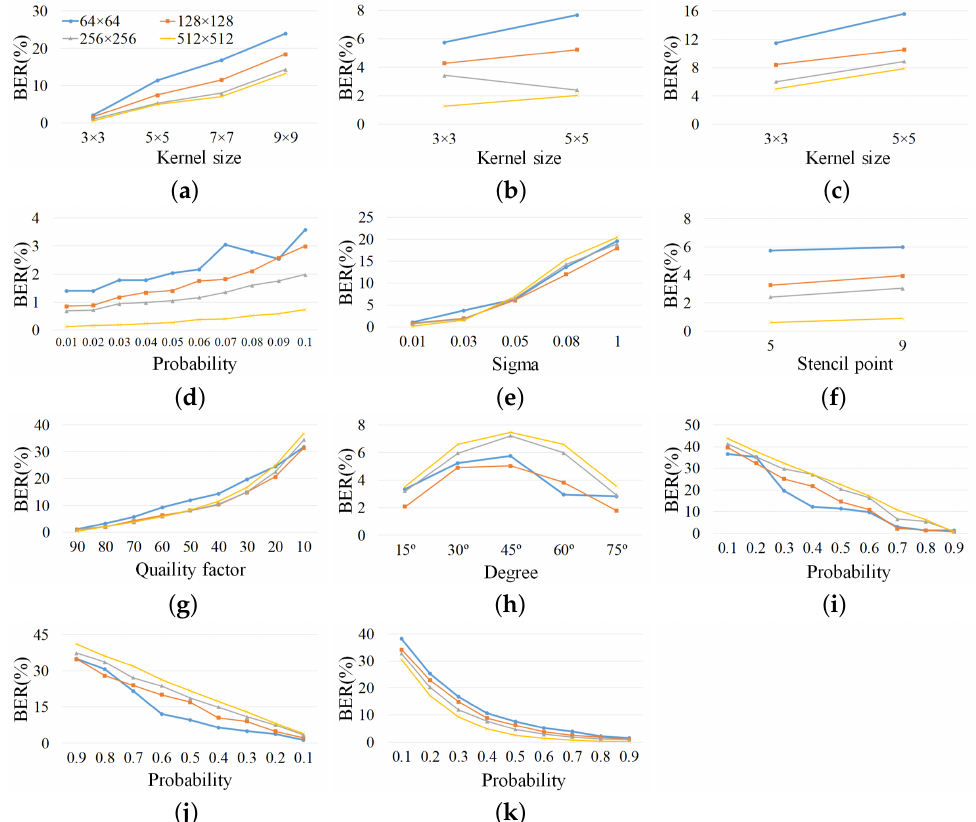
Figure 6. BER values resulting from the experiments for the various sizes of host image (the legend in ( a ) is applied to all the figures): ( a ) Gaussian Filtering, ( b ) average Filtering, ( c ) median Filtering, ( d ) salt and pepper noise addition, ( e ) Gaussian noise addition, ( f ) sharpening, ( g ) JPEG, ( h ) rotation, ( i ) crop, ( j ) cropout, ( k )